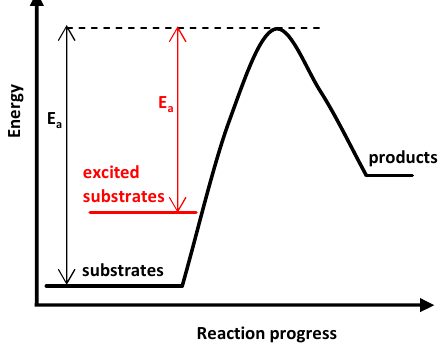
Figure 3. The effect of molecule excitation on the activation energy (E a ). It is noteworthy that the effect of the catalyst on hydrogen production was more sig- nificant than on ethanol conversion due to the increase in CO 2 production (Figure 4).